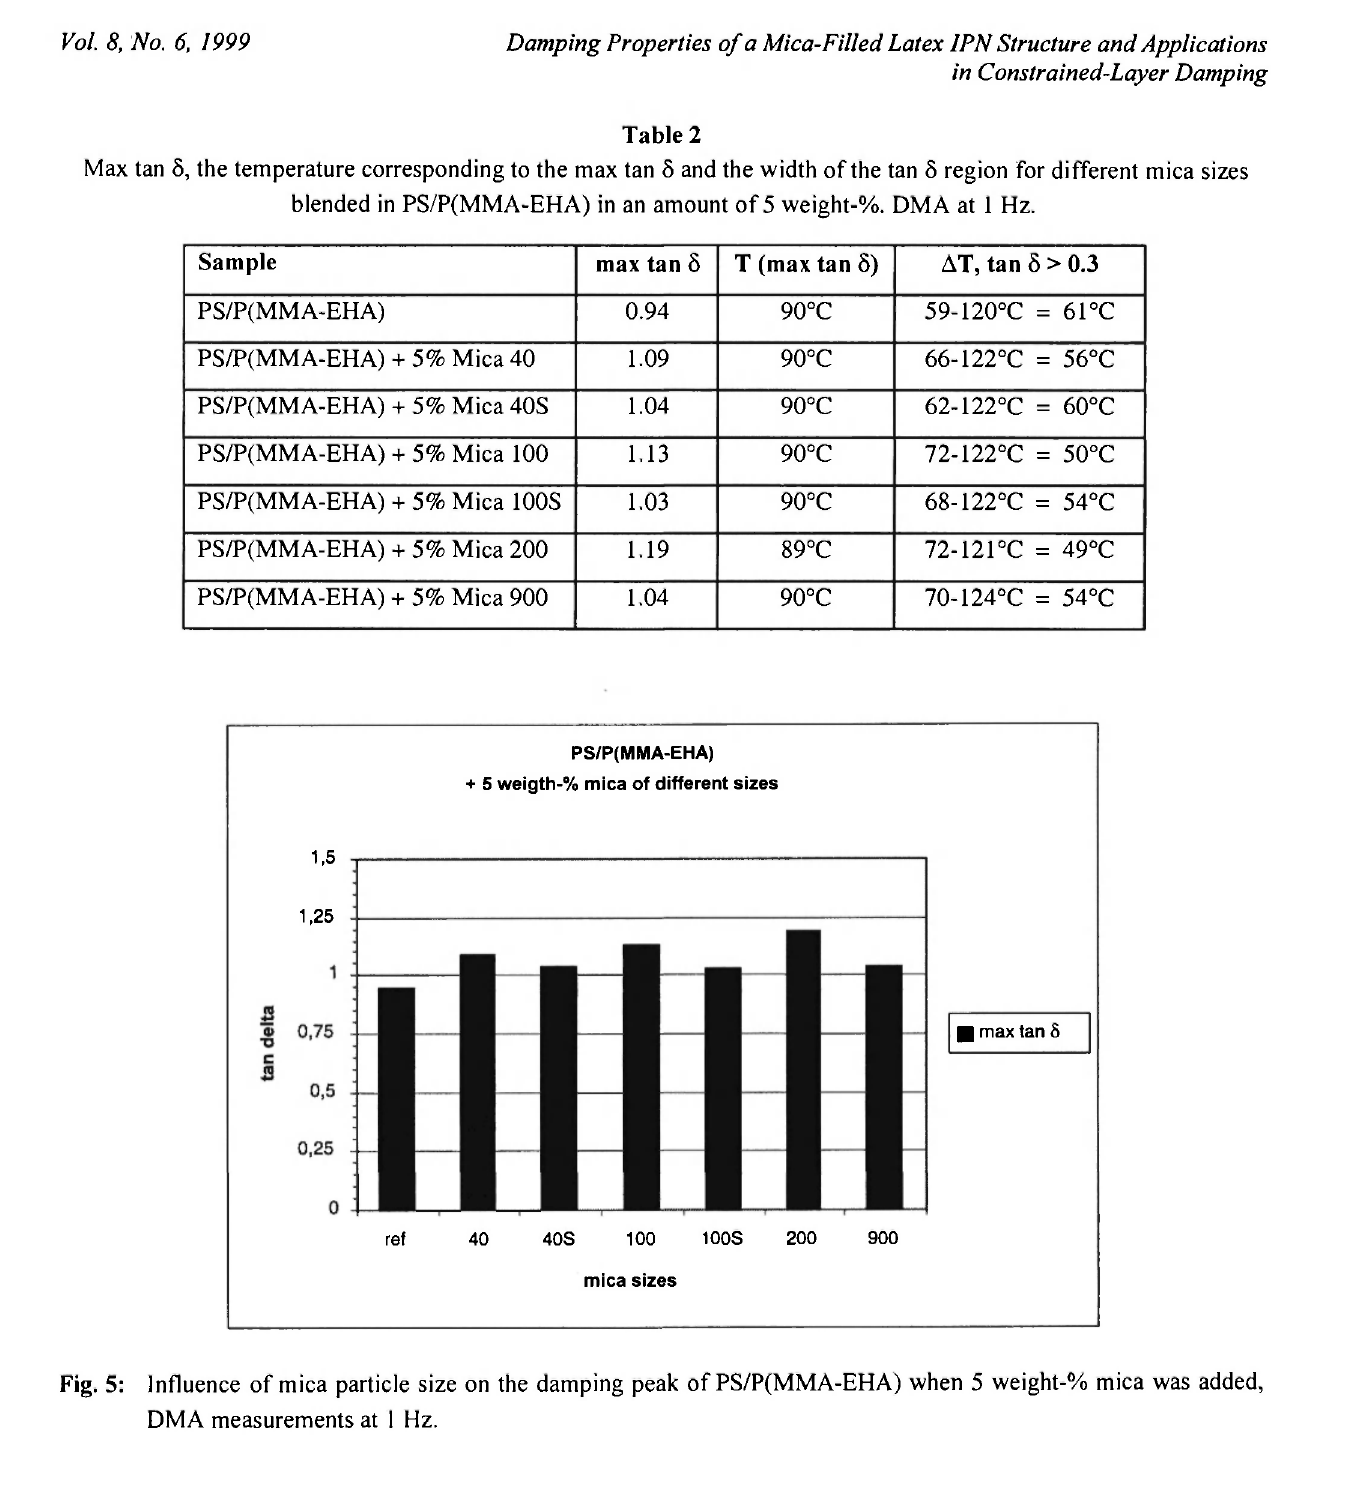
Fig. 5: Influence of mica particle size on the damping peak of PS/P(MMA-EHA) when 5 weight-% mica was added, DMA measurements at l